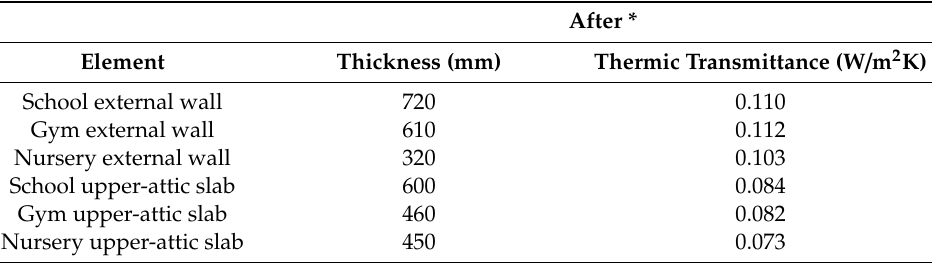
Table 8. Oulx envelope system characteristics (after intervention A4).